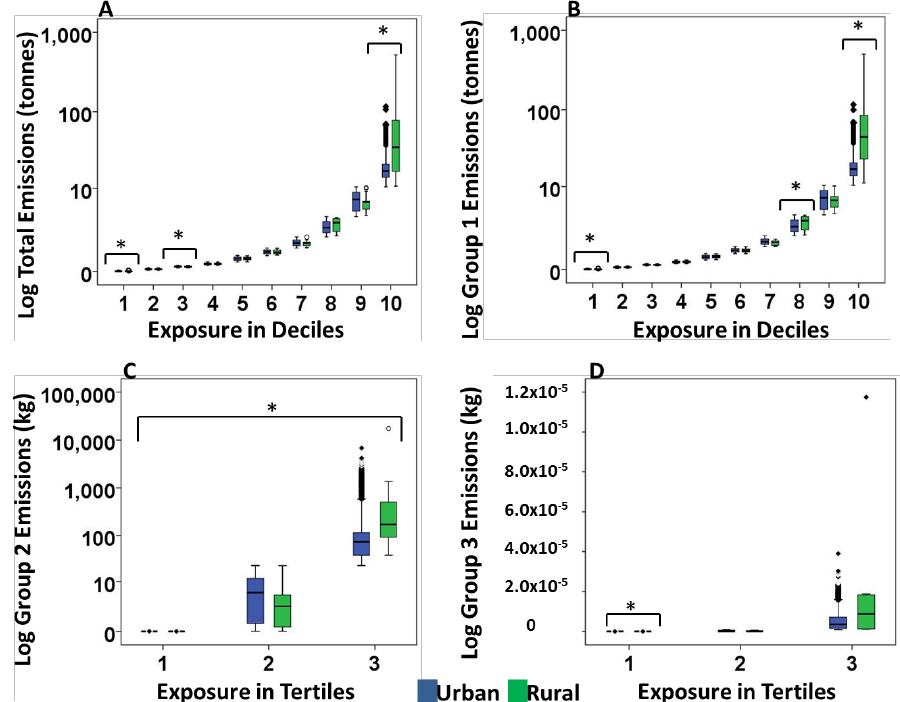
Figure 1. Distribution of inverse distance weighted (IDW) exposure in urban and rural Alberta. ( A )